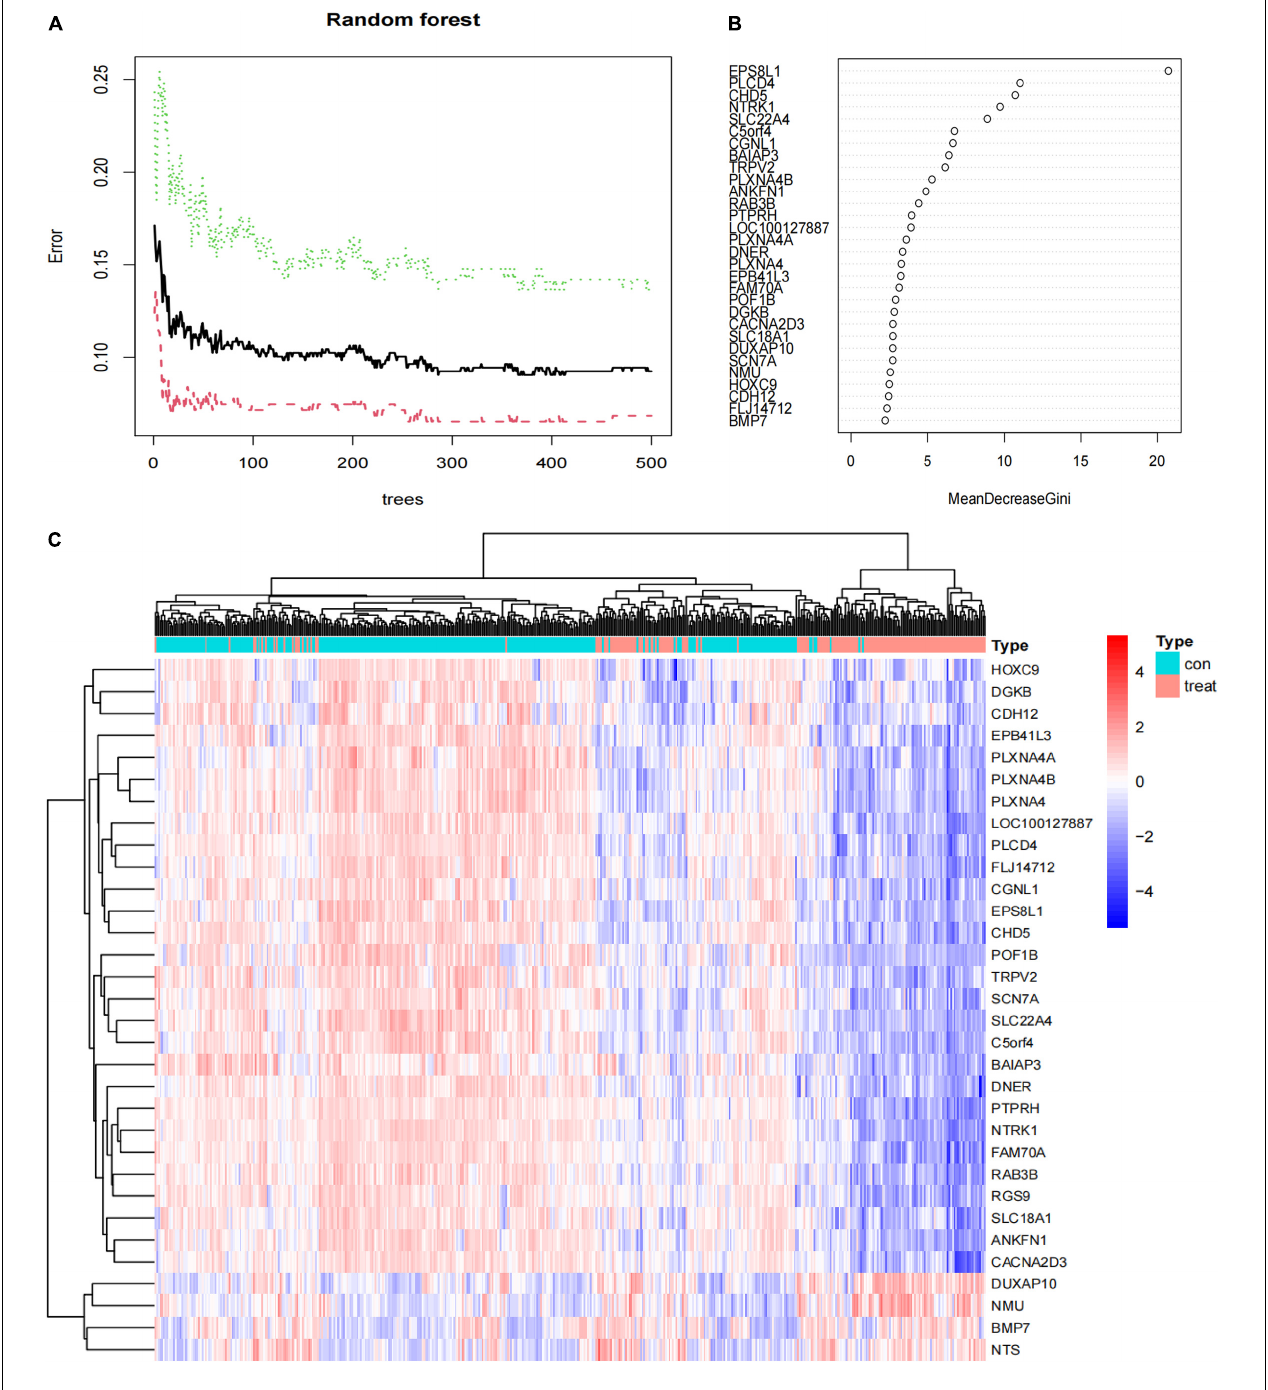
FIGURE 5 | The results of the top 30 genes screened by random forest. (A) The plot of performance in log scale against epoch number; (B) the importance of the top 30 genes ranked by the mean decrease of accuracy; (C) heat map of the top 30